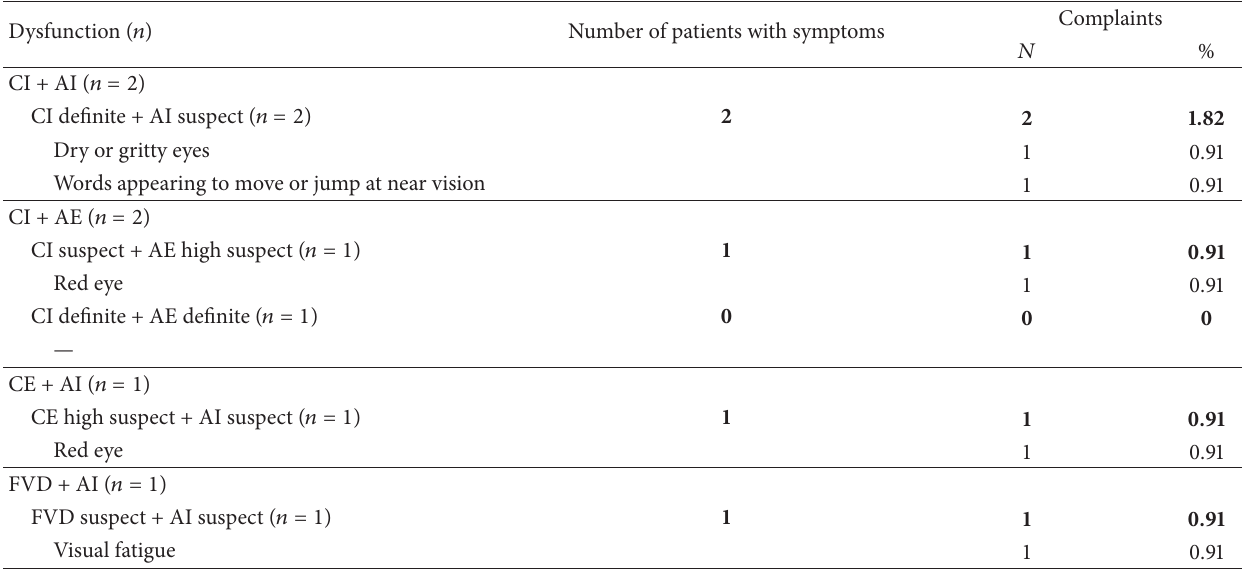
Table6:Symptomsrelatedtosubjectswithbothaccommodativeandbinoculardysfunctions(CI:convergenceinsufficiency;CE:convergence insufficiency; AI: accommodative insufficiency; AE: accommodative excess; FVD: fusional vergence dysfunction).